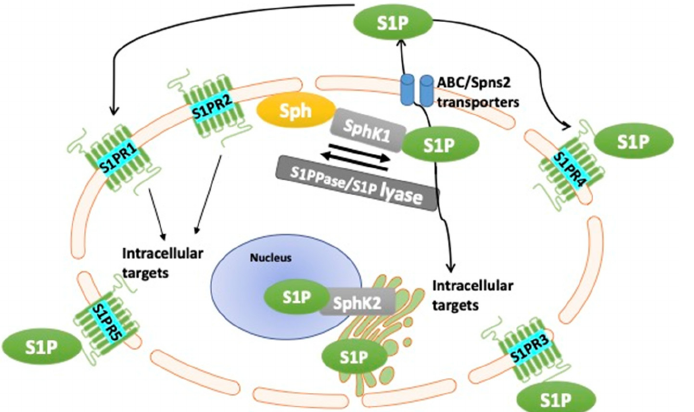
Figure 1. Sphingosine kinase (SphK)/sphingosine-1-phosphate (S1P) inside–outside model. SphK1 is primarily located in the cytosol and SphK2 is mainly localised in the inner mitochondrial membrane, the endoplasmic reticulum, and the nucleus. Sphingosine (Sph) is converted to S1P via SphKs and this process can be reversed via S1P phosphatases (S1PPase), which dephosphorylate S1P or